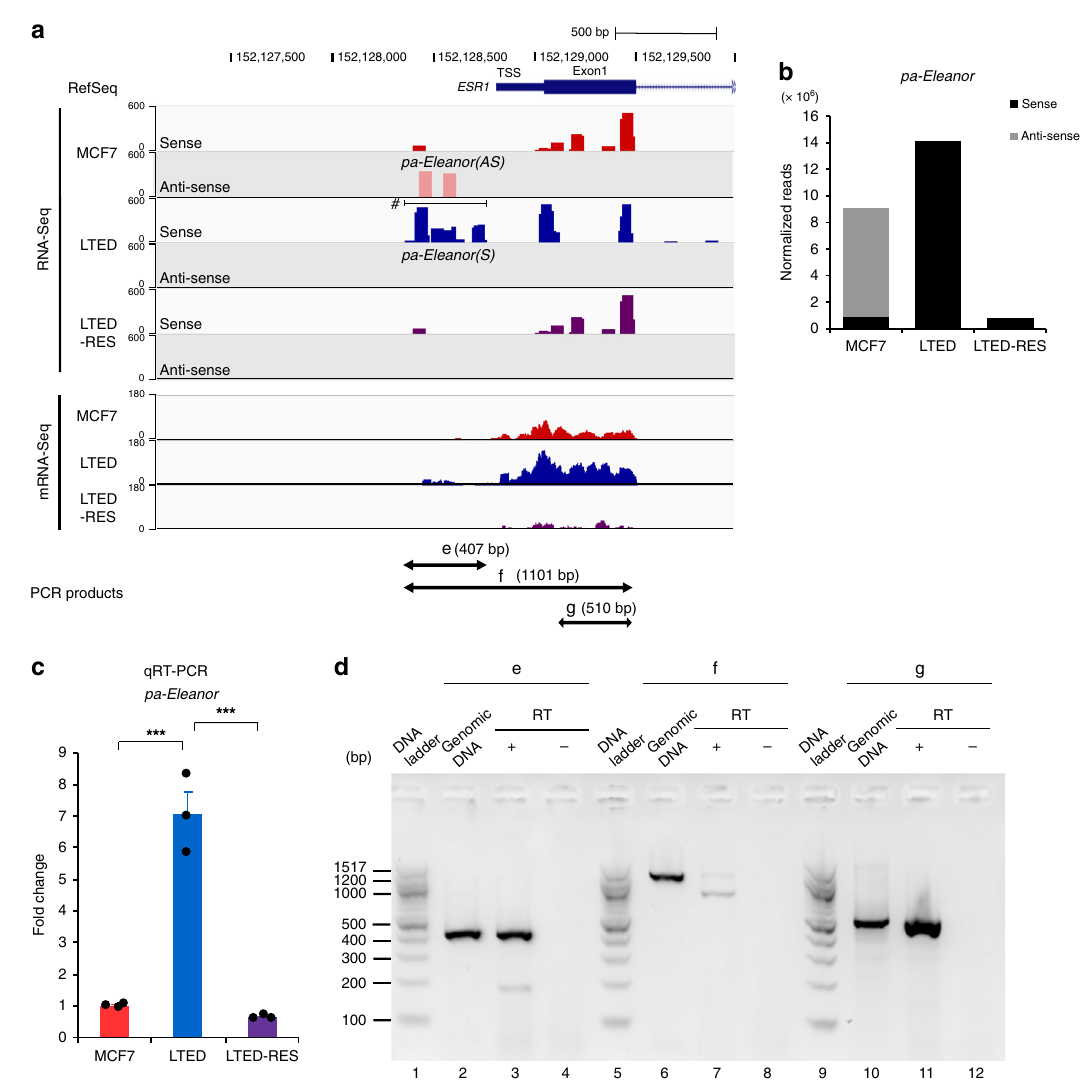
Fig. 4 The ESR1 promoter is transcribed differentially in MCF7 and long-term estrogen deprivation (LTED) cells. a Alignment of RNA-Seq and mRNA-Seq of the human ESR1 promoter-proximal region in the indicated cells 27 . Peaks in RNA-Seq indicate transcripts with sense (dark colors) and antisense (pale colors) orientation relative to the ESR1 gene. In MCF7 cells, antisense transcription was detected at the transcription start site (TSS), which then switched to opposite direction to produce pa-Eleanor(S) (denoted by the horizontal bar with hash (#)) in LTED cells. Positions of the PCR products (e – g) in d are shown at the bottom. b Number of sequencing reads mapped at the TSS of the ESR1 gene. Numbers corresponding to sense and antisense RNA were counted and normalized according to the total number of mapped reads. c Expression levels of pa-Eleanor in the indicated cells determined with quantitative reverse transcription polymerase chain reaction (qRT-PCR). Values in MCF7 cells were set to 1. Data are representative of three independent experiments (mean ± s.e.m.). P values were calculated using unpaired, two-tailed, Student ’ s t test (*** P < 0.001). d Local expression of pa-Eleanor(S) at site e in LTED cells. RT-PCR to amplify predicted transcripts as shown in a (e – g) resulted in successful detection of the e-fragment ( pa-Eleanor , lane 3) and g-fragment (exon1 of ESR1 , lane 11) by electrophoresis but not the f-fragment (lane 7). These results indicate that pa-Eleanor(S) is not contiguous with the ESR1 mRNA. All primers and ampli fi cation conditions were validated with PCR in parallel with genomic DNA as a template and RT-PCR with and without